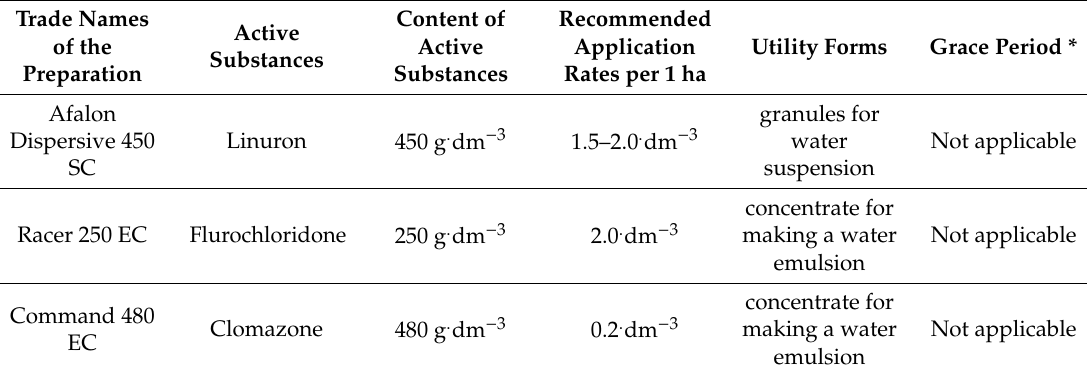
Table 2. Characteristics of the herbicides and herbicide additives used in the experiment. Recommended Content of Trade Names Active Active of the Substances Substances Preparation Afalon Dispersive